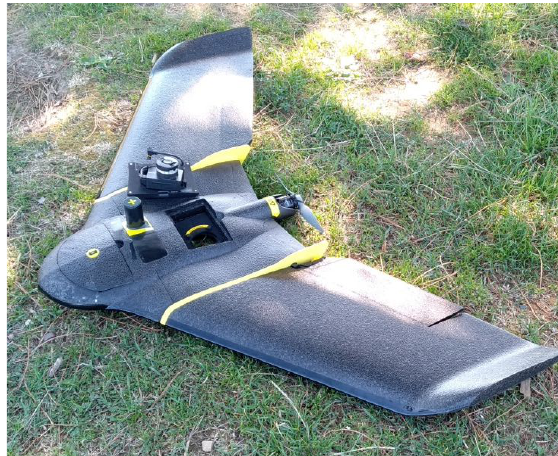
Figure 2. The eBee plus RTK fixed-wing UAV used in this work.